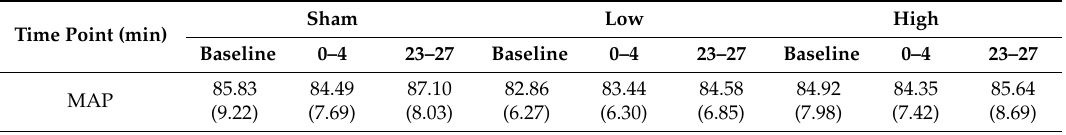
Table 3. Mean arterial pressures (MAP) values at Baseline, the beginning, and end of RF-EMF exposure for the Sham, Low, and High Exposure conditions (standard errors in